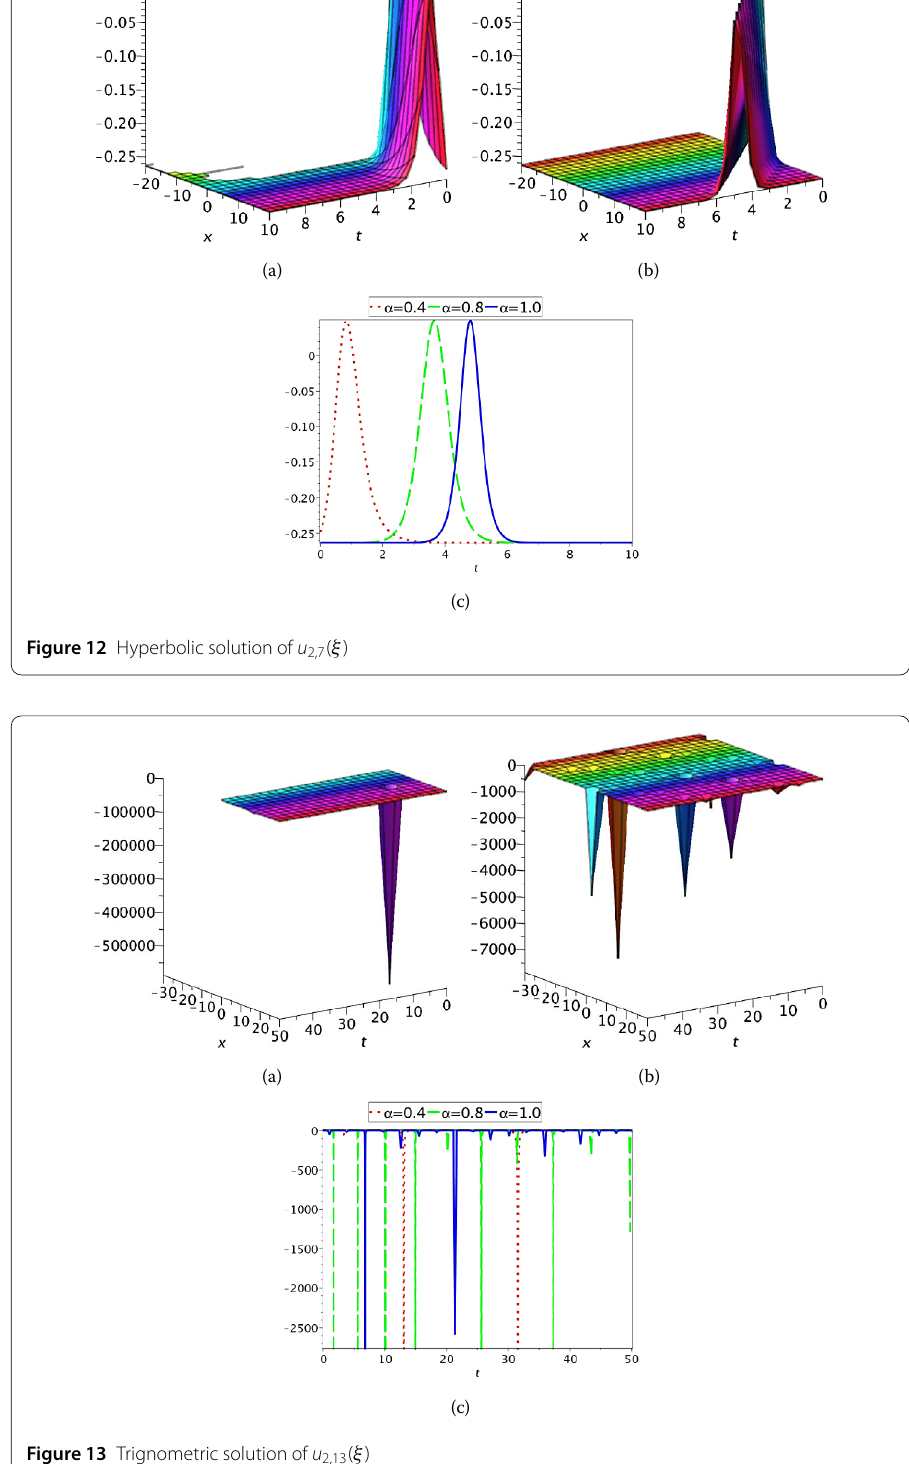
Figure 13 Trignometric solution of u 2,13 ( ξ